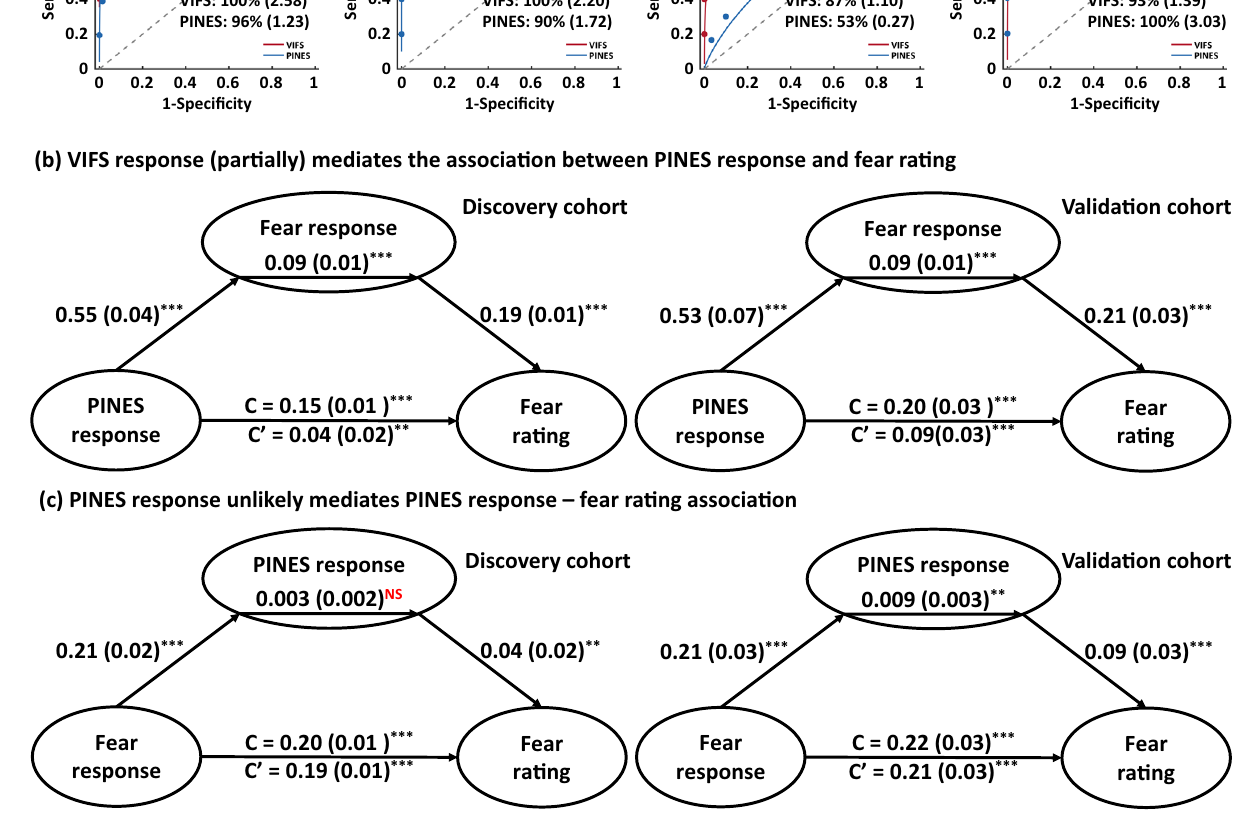
Fig. 6 Comparing VIFS and PINES responses. a depicts that VIFS more accurately (shown as forced-choice classi fi cation accuracy and Cohen ’ s d ) predicts high versus low subjective fear while PINES is more sensitive to distinguish high versus low general negative emotion. b shows the multilevel mediation analysis results showing that VIFS response mediates the PINES response — fear rating association in both discovery and validation cohorts. c shows that the PINES response does not mediate the VIFS response — fear rating association in the discovery cohort. Although the mediation effect is signi fi cant in the validation cohort, the effect size (Cohen ’ s d = 0.06) is very small. ** indicates P < 0.01, *** P < 0.001, NS P > 0.5 (bootstrap tests; two-sided; uncorrected).